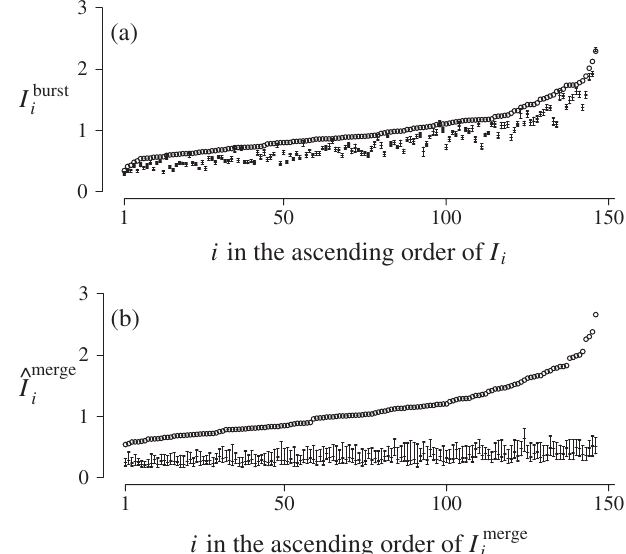
FIG. 5. Results of the bootstrap test for D . The circles repre- 1 sent I i and I merge i in (a) and (b), respectively. The error bars represent the statistics for the bootstrap samples. (a) Results of the shuffling test. I i and the error bars are plotted in the ascend- ing order of I i . The error bars indicate 1 standard deviation around the mean of I burst i , which was obtained from 100 shuffled partner sequences. The ticks at the middle of the error bars indicate the mean. (b) Results of the merging test. I merge i and the confidential intervals (error bars) are plotted in the ascending order of I merge i . The lower and upper ends of the error bars represent 0 and 99 percentile points, respectively. The ticks at the middle of the error bars indicate the